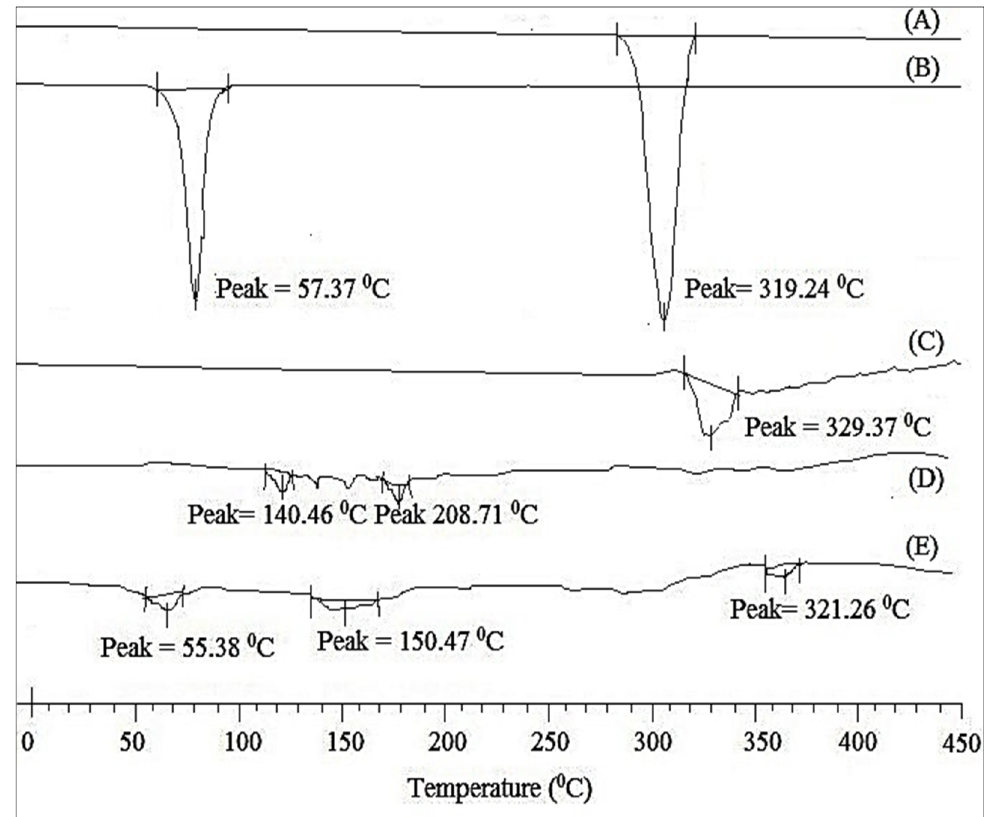
Figure 5. DSC thermogram of ( A ). CEP; ( B ). Poloxamer 188; ( C ) Lauroglycol 90; ( D ) Transcutol-HP; ( E ) CEP-SNEDDS (Opt-F3).